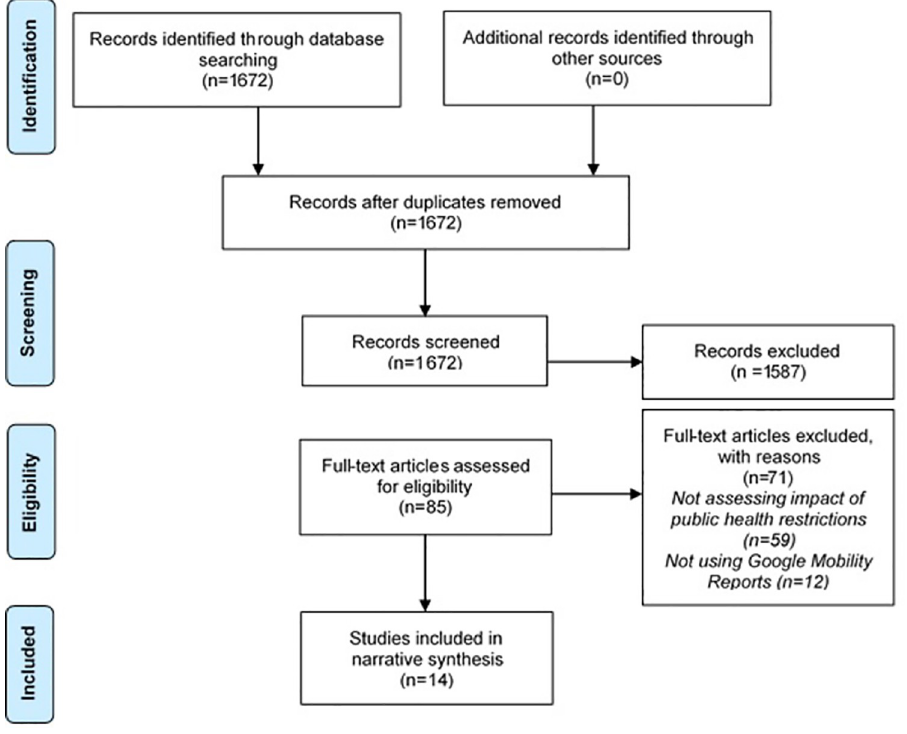
Fig 1. PRISMA flow